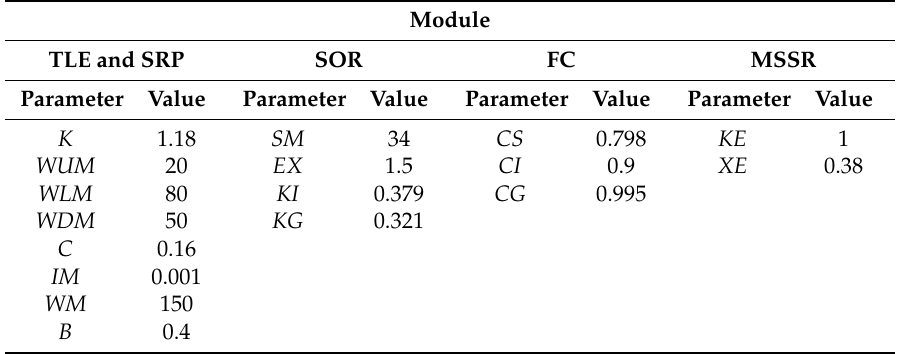
Table 4. Parameters of the XAJ model for Qilijie basin.